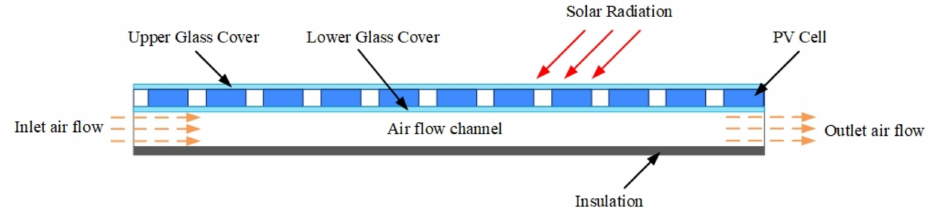
Figure 1. Schematic cross-sectional view of